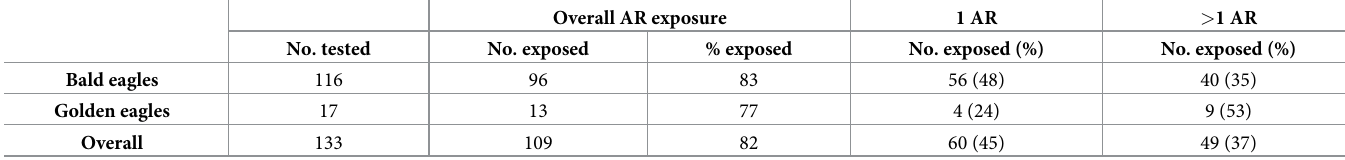
Table 1. Percent exposure and number of anticoagulant rodenticide (AR) compounds detected in bald and golden eagles submitted to the Southeastern Cooperative Wildlife Disease Study (University of Georgia), 2014–2018.